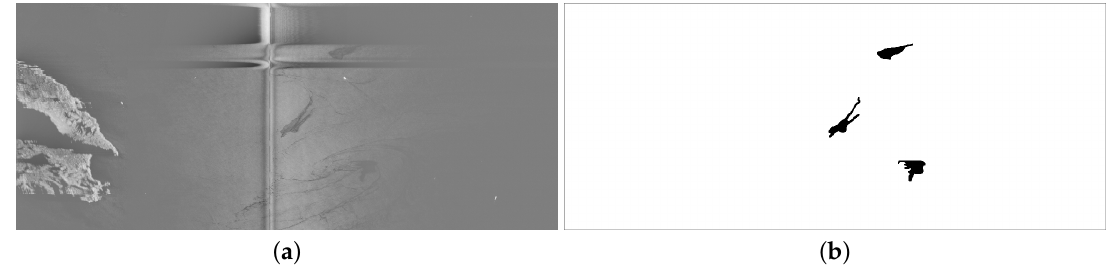
Figure 2. Example of a SLAR sequence from our dataset ( a ) and its corresponding ground truth ( b ) with the oil spills labeled at the pixel level. The SLAR image shows an island on the left side, a vertical zone of noise caused by junction of the signal from the two antennas of TERMA radar, and two horizontal bands of noise at the top produced by aircraft